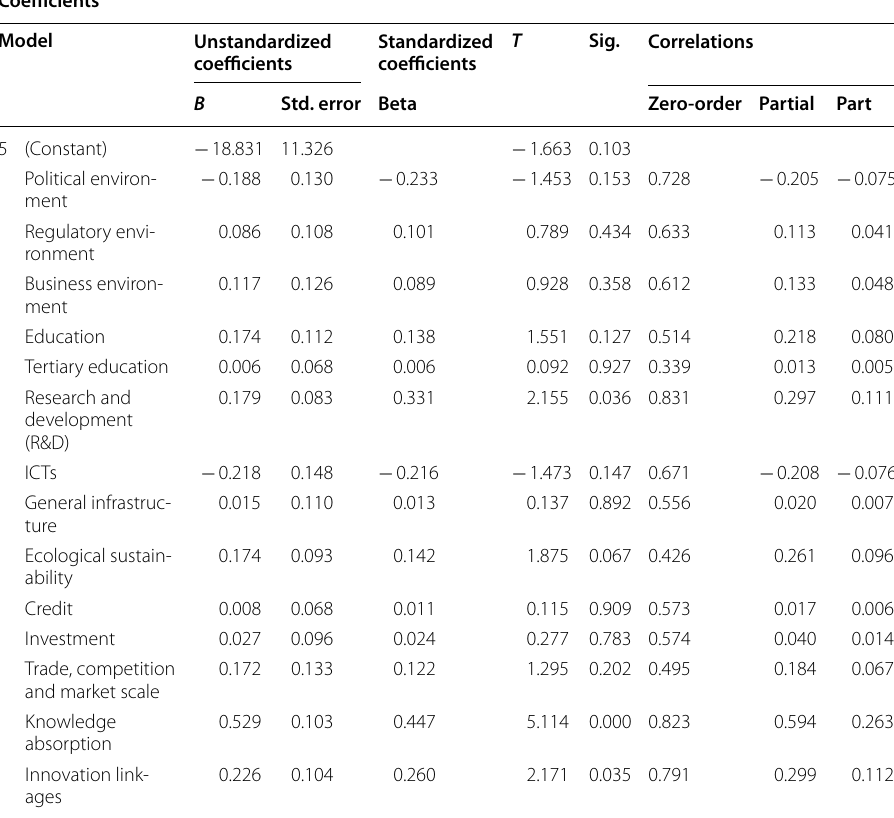
a Dependent variable: knowledge and technology